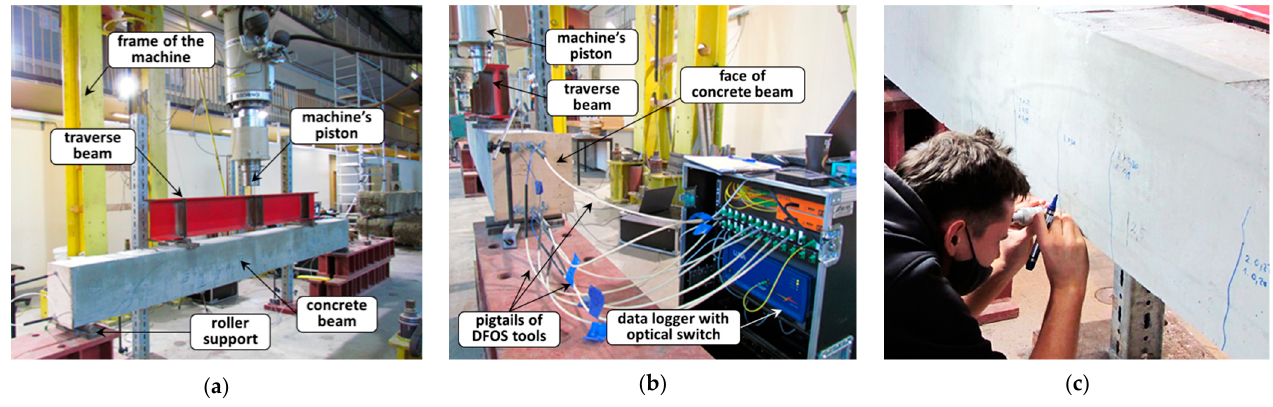
Figure 10. ( a ) Example beam during four-point bending test; ( b ) Rayleigh-based data logger with an optical switch connected to embedded DFOS tools; ( c ) reference readings.